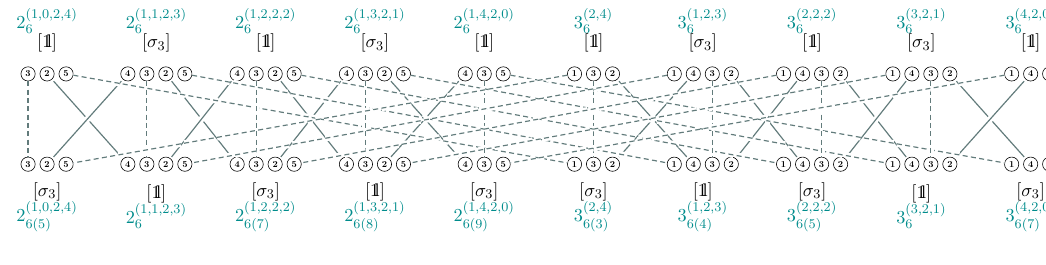
Figure 11 . T -duality chain of the E (7;2) -branes.